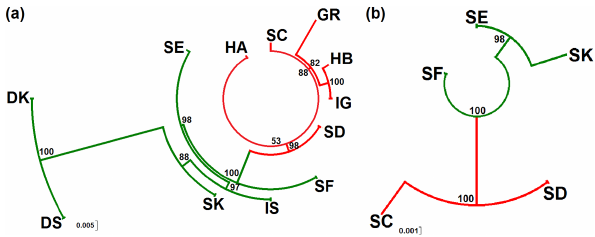
Figure 2. Un-rooted neighbour joining (NJ) trees based on Nei’s genetic distances for (a) the full data set and (b) Surtsey only. Boot- strap values are shown at the nodes. Population names are abbrevi- ated as in Table 1. The two colours, green and red, represent clusters I and II in Fig. 1,